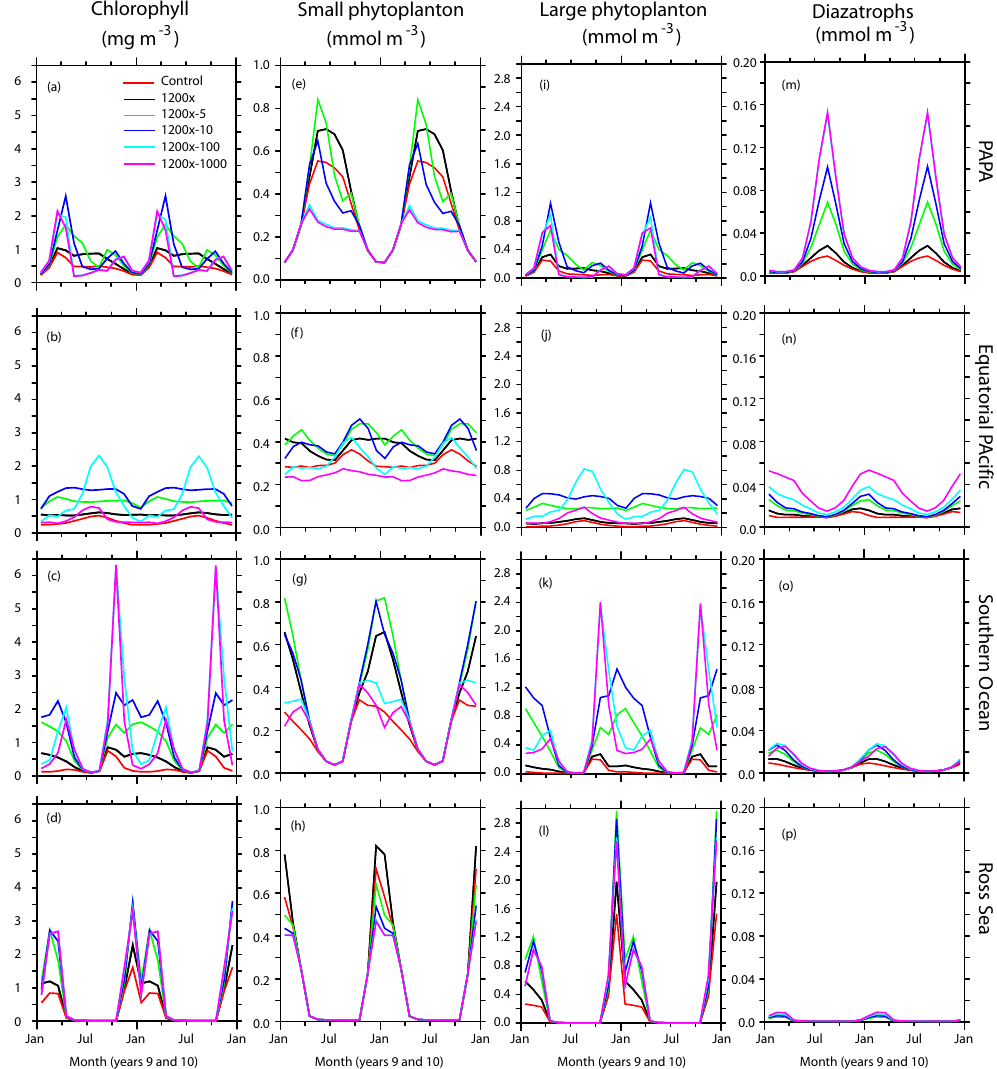
Fig. 14. Mean chlorophyll, and nitrogen in small phytoplankton, large phytoplankton, and diazotrophs in the top 10m of the four fertilization sites after 10 years of constant fertilization with increasing additions of iron expressed here as a multiple of the standard 1200x